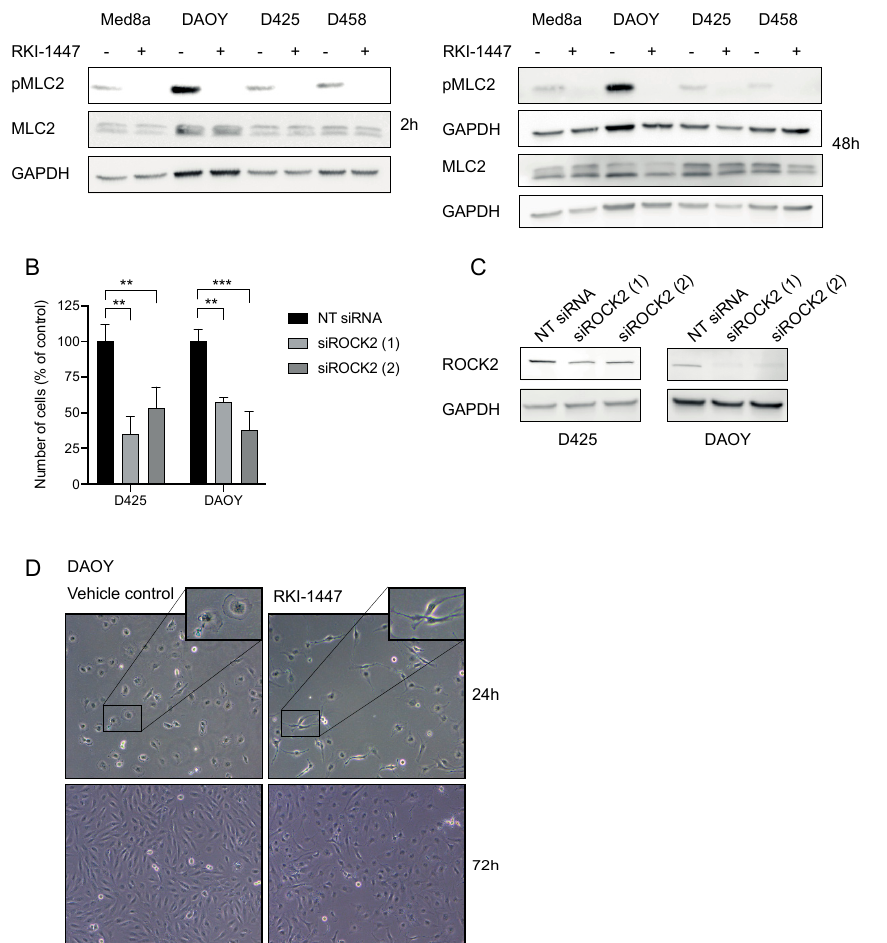
Figure 3. RKI-1447 inhibits phosphorylation of MLC2 in medulloblastoma cells ( A ) RKI-1447 inhibited downstream signaling in the Rho/ROCK pathway assessed by protein expression of phosphorylated MLC2 (Ser19) (18 kDa) compared to total MLC2 (18 kDa) and loading control GAPDH (36 kDa) at 2 h incubation, as well as phosphorylated MLC2 (Ser19) compared to total MLC2 (18 kDa) and GAPDH at 48 h treatment. Protein expression was investigated in RKI-1447 and vehicle-treated Med8a (1 µM),